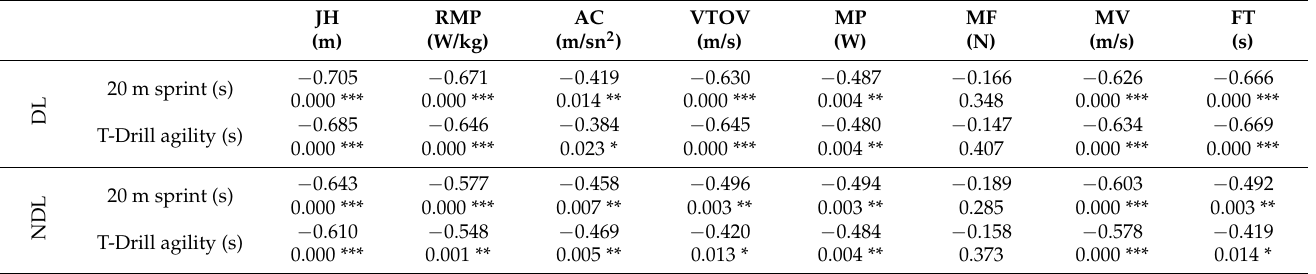
Table 2. Correlation coefficients between the single-leg CMJ and sprint/agility scores for dominant and non-dominant legs.